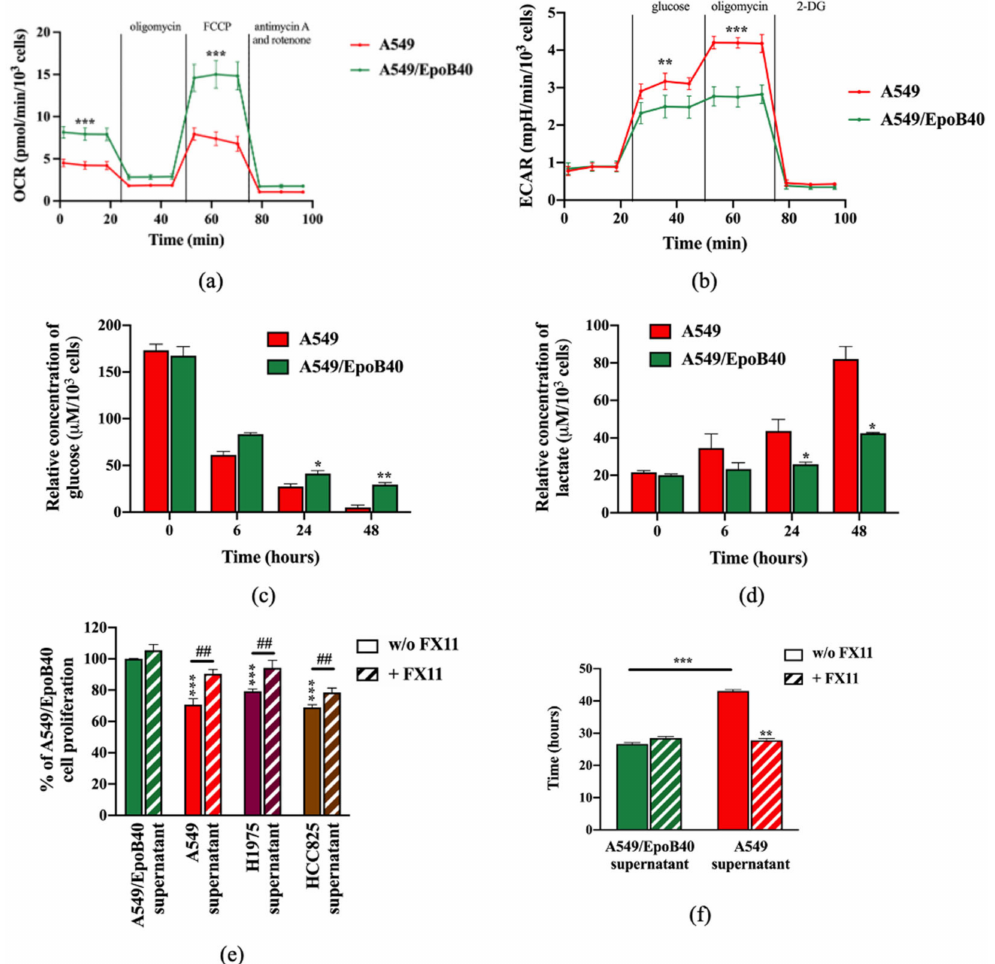
Figure 6. Drug-sensitive A549 clones have a higher glycolytic profile than drug-resistant A549/EpoB40 clones. ( a , b ) A549 and A549/EpoB40 cells were analyzed for ( a ) mitochondrial bioenergetics and ( b ) glycolysis using the Seahorse XF technology (OCR: Oxygen Consumption Rate and ECAR: ExtraCellular Acidification Rate). ( c , d ) Supernatants from A549 and A549/EpoB40 were collected over time and analyzed for ( c ) glucose consumption and ( d ) lactate production by using the YSI 2900 instrument. ( e ) A549/EpoB40 cell proliferation was measured by crystal violet assay at 72 h after daily exposition to cell-free supernatants from A549, H1975 or HCC825 cultures previously incubated with or without 3 µ M of FX11. Supernatants from A549/EpoB40 cultures that were subjected to the same treatment were used as a control. Results were expressed as a percentage of control cell proliferation. ( f ) A549/EpoB40 cell growth was followed by a real-time impedance-based method. A549/EpoB40 cells were exposed daily to cell-free supernatants from A549 and A549/EpoB40 cultures that were previously incubated with or without 3 µ M of FX11. Doubling time of A549/EpoB40 cells was calculated in different conditions. Data are shown as means ± SEM. * p < 0.05; ** p < 0.01; *** p < 0.001; ## p < 0.01 (* comparison to A549/EpoB40 supernatant w/o FX11 and # comparison between w/o FX11 and FX11 treated